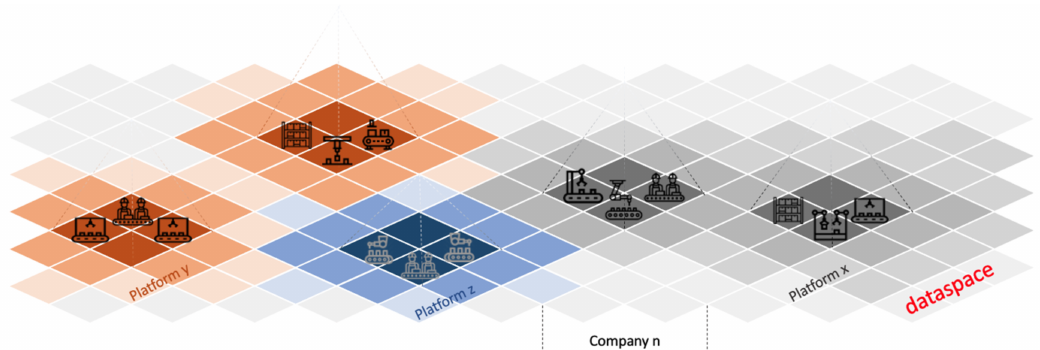
Figure 2. Leveling the data